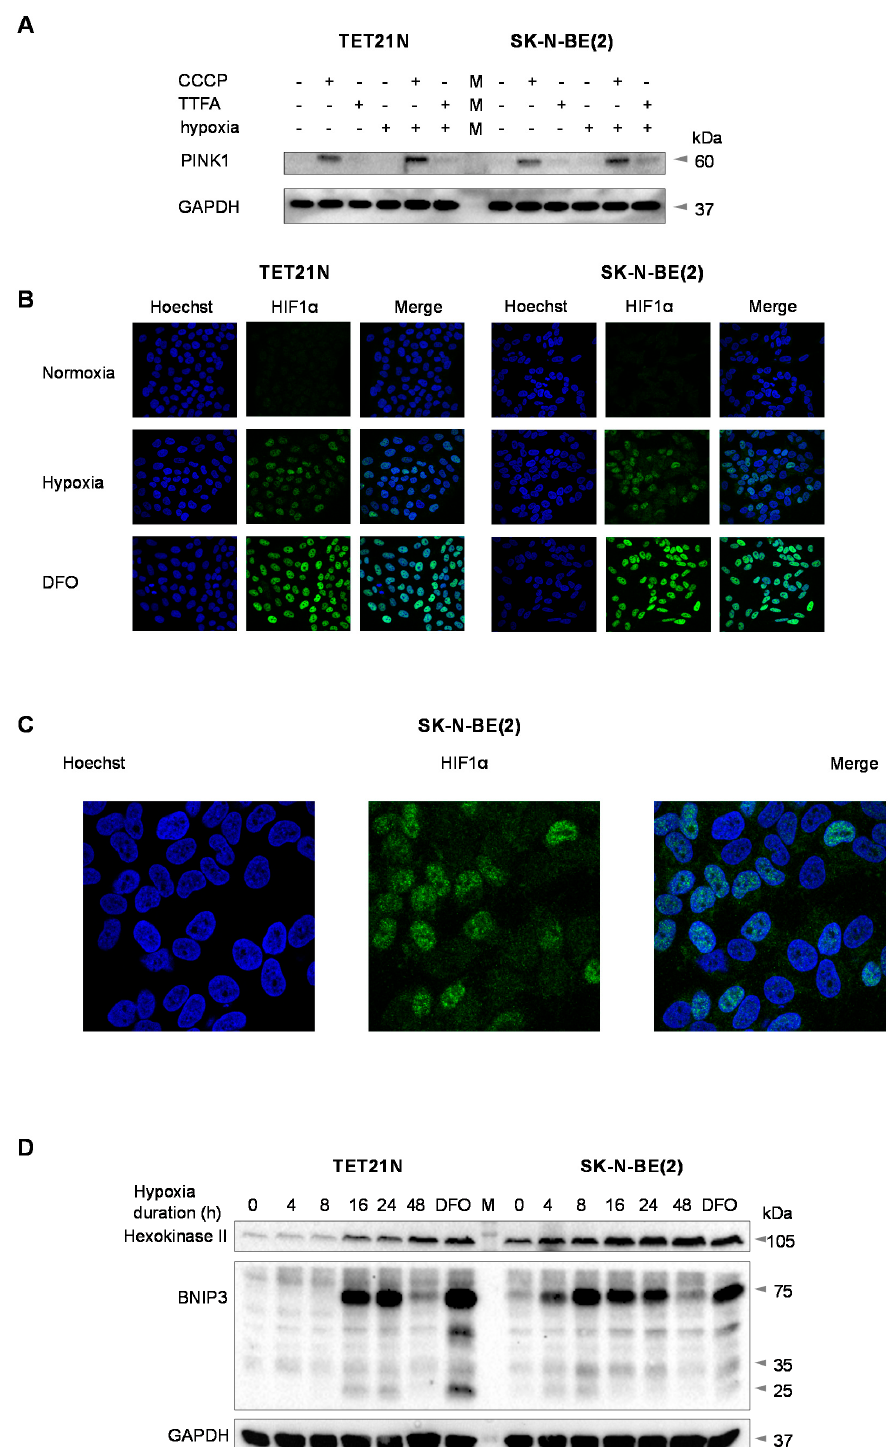
Figure 3. The consequences of hypoxia in Tet21N and SK-N-BE(2) neuroblastoma cells. Assessment of PINK1 accumulation ( A ), HIF1 α stabilization and its colocalization with nucleus, stained with Hoechst ( B ), high-magnification images of HIF1 α colocalization with nucleus in SK-N-BE(2) cells under hypoxic conditions ( C ), time-dependent accumulation of hexokinase II and BNIP ( D ). Deferox- amine (DFO) was used as a chemical mimetic of hypoxia, and GAPDH as a loading control. Scale bar: 20 µ